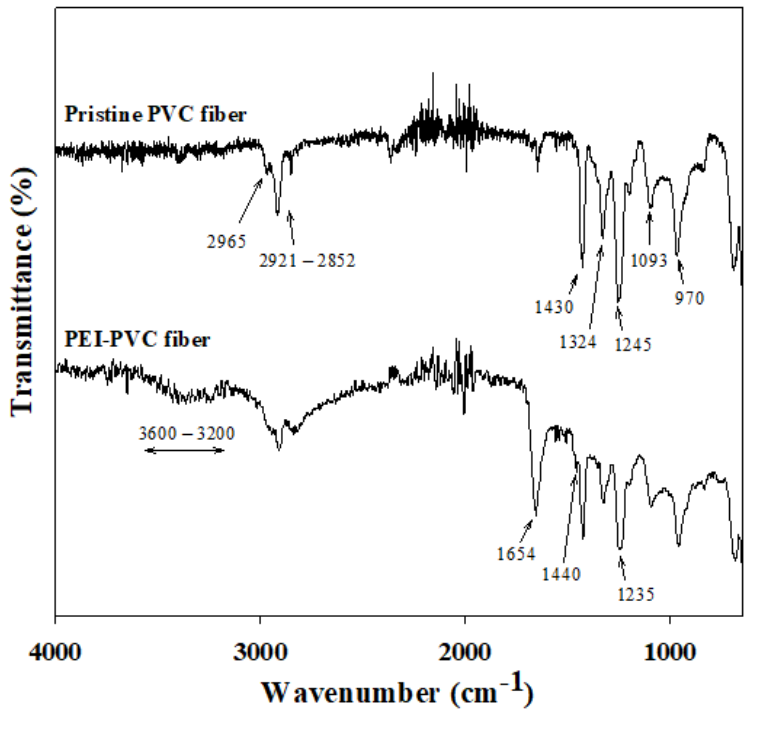
Figure 1. FT-IR spectrum of PVC and PEI-PVC.